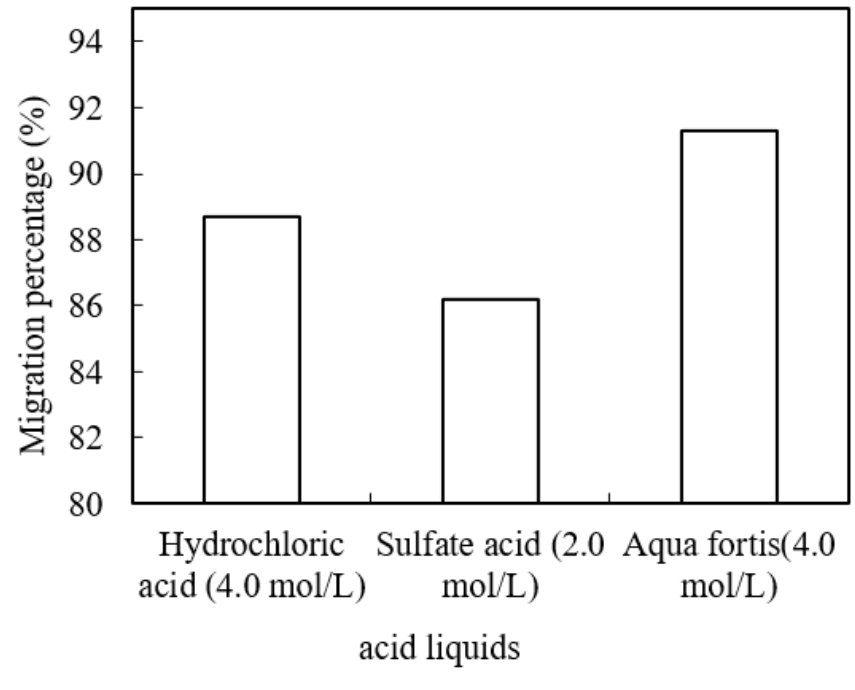
Figure 10. Effects of using different acid liquids as stripping agents.